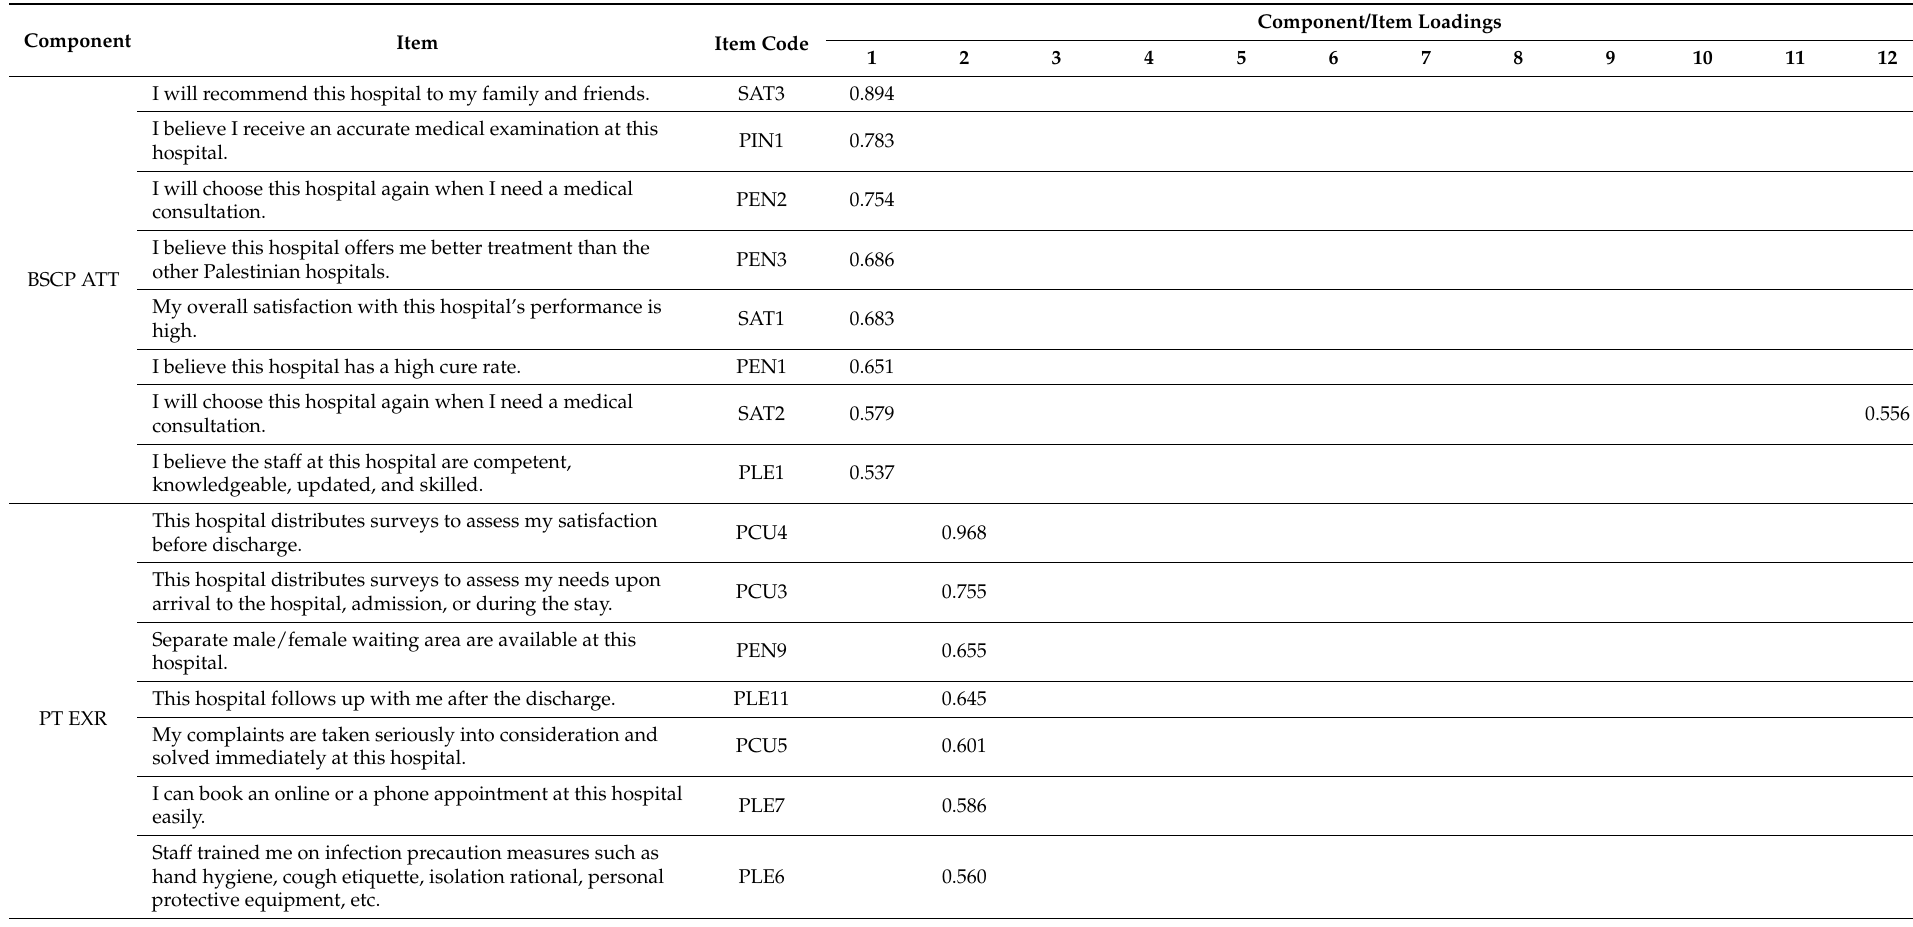
Table 4. Exploratory factor analysis